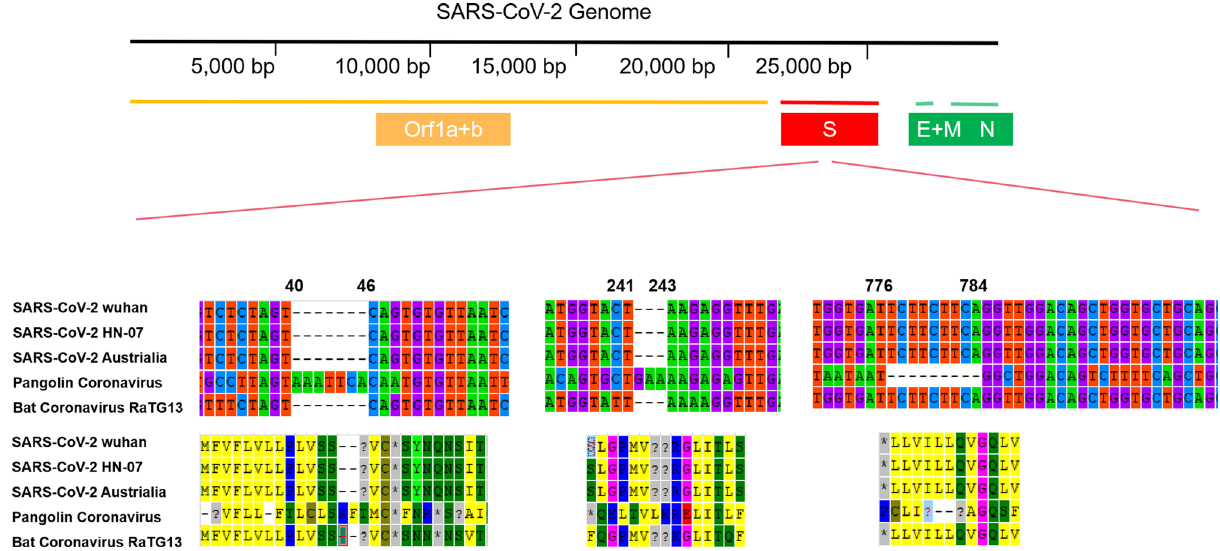
Figure 2. The sequence and amino acid alignment of the S gene in SARS-CoV-2 and coronaviruses found in bat and pangolin. The genomic structure of SARS-CoV-2 is shown in upper, the nucleic sequences alignment is shown in the middle while the amino acid is shown at the bottom of the figure.